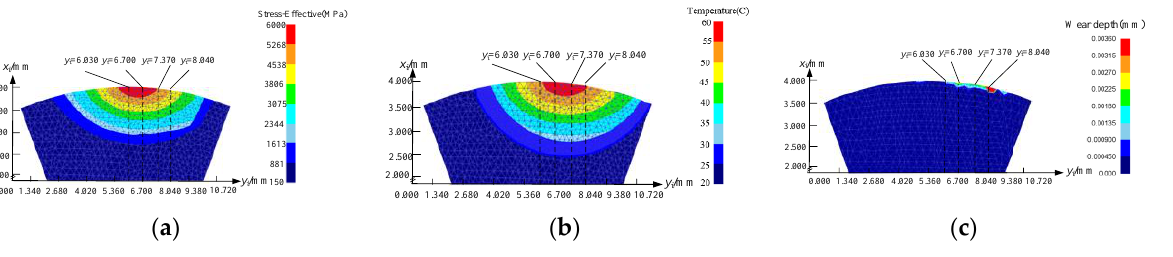
Figure 6. Finite element stress field distribution of the tool flank: ( a ) equivalent effect distribution; ( b ) temperature distribution; ( c ) wear depth distribution.